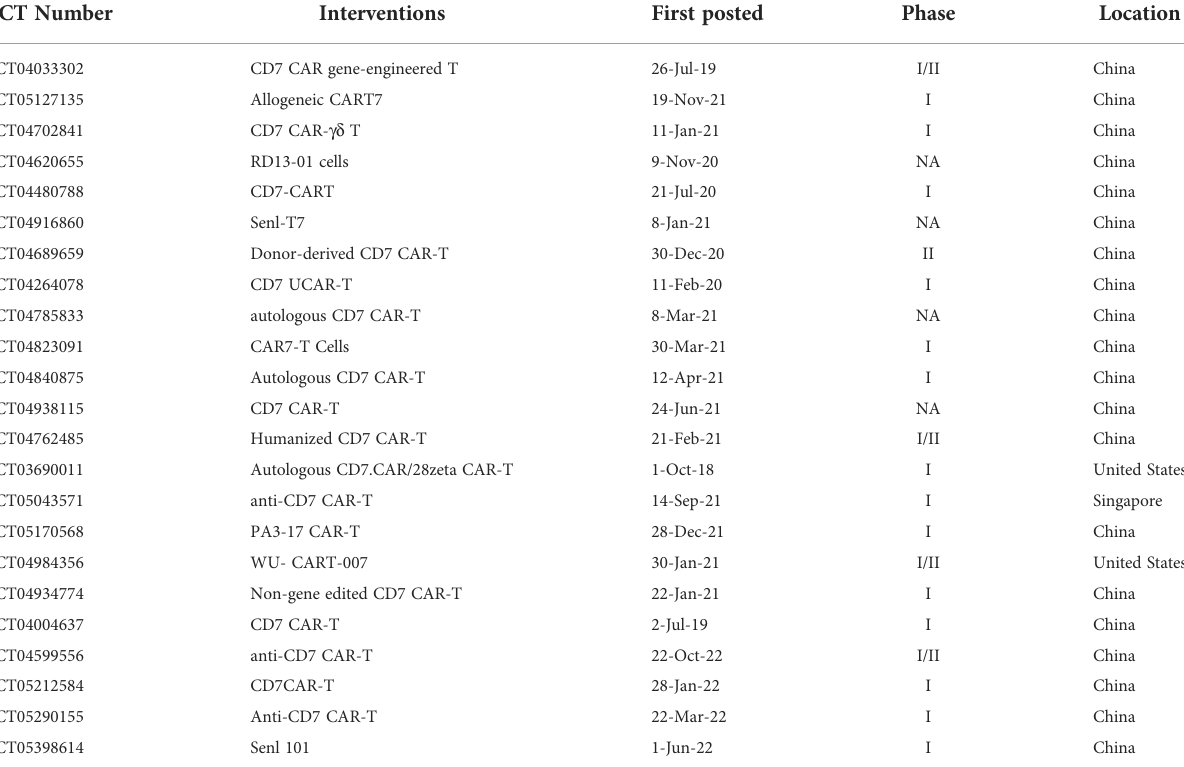
TABLE 2 Recruiting CD7 CAR clinical